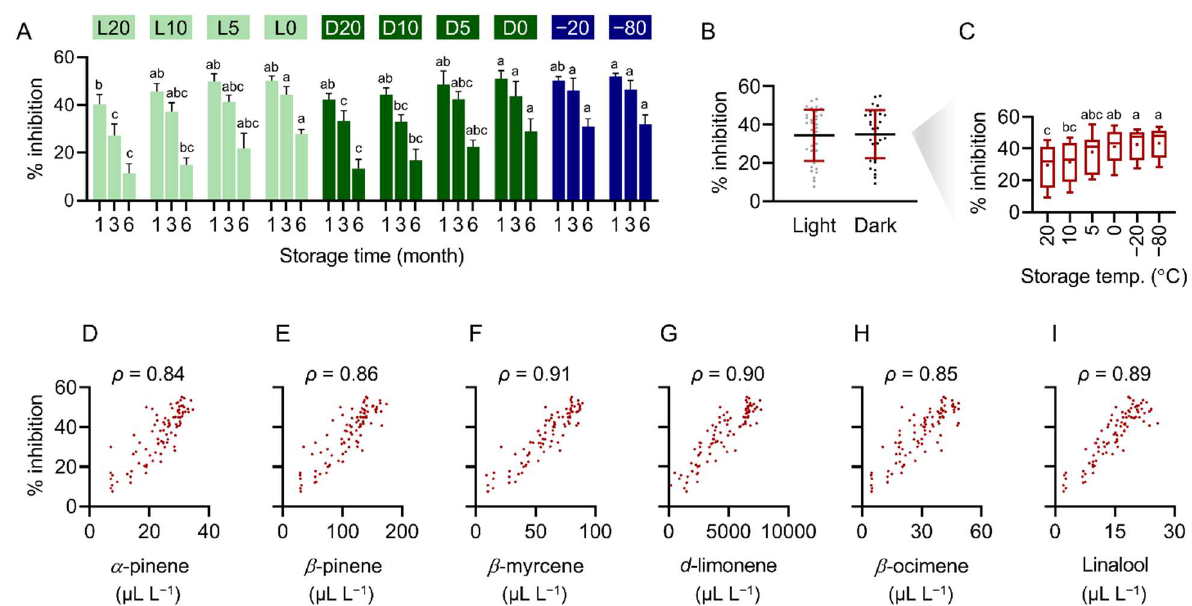
Figure 5. Correlation between the major constituents and antifungal activity of pomelo extract. ( A ) The relative growth of C. gloeosporioides on PDA plates prepared with 4 mL L − 1 PE stored under indicated conditions and storage time. Data are presented as mean ± SD. ( B ) Antifungal activity of PE samples stored with or without light protection. Data are presented as mean ± SD and individual values as dots. ( C ) Antifungal activity of PE samples stored at 20°, 10°, 5°, 0°, −20°, and −80 °C. Data are presented in box and whisker plots showing the minimum, first quartile, median, third quartile, and maximum values, and the means of data are indicated by dots. Analysis of correlation between the antifungal activity and the concentration of ( D ) α -pinene, ( E ) β -pinene, ( F ) β -myrcene, ( G ) d -limonene, ( H ) β - ocimene, and ( I ) linalool. Significant differences among storage conditions are indicated by different alphabets (Tukey’s tests; p < 0.05, A: n = 3; B: n = 36; C: n = 9; D–I: n = 90).